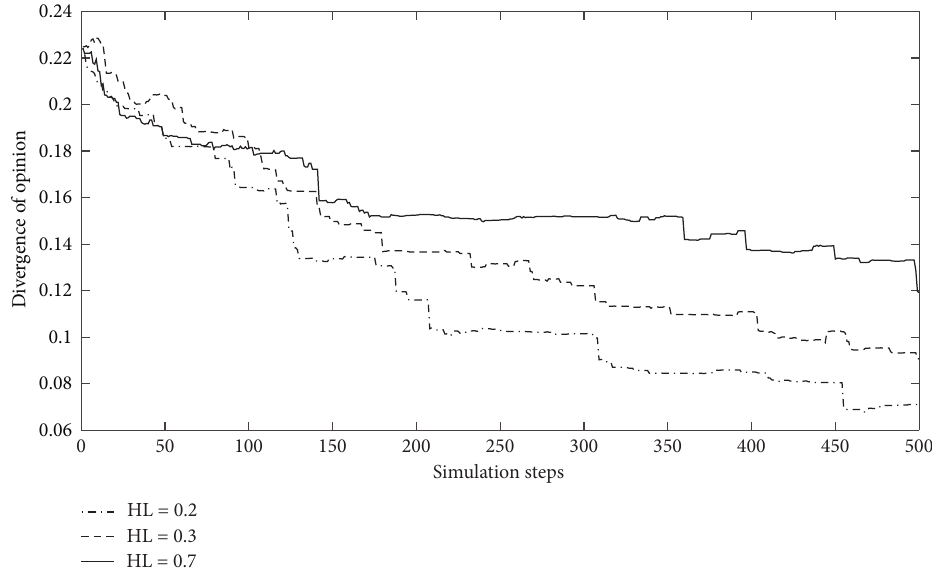
Figure 7: Influence of proportion of high education individuals on the process of